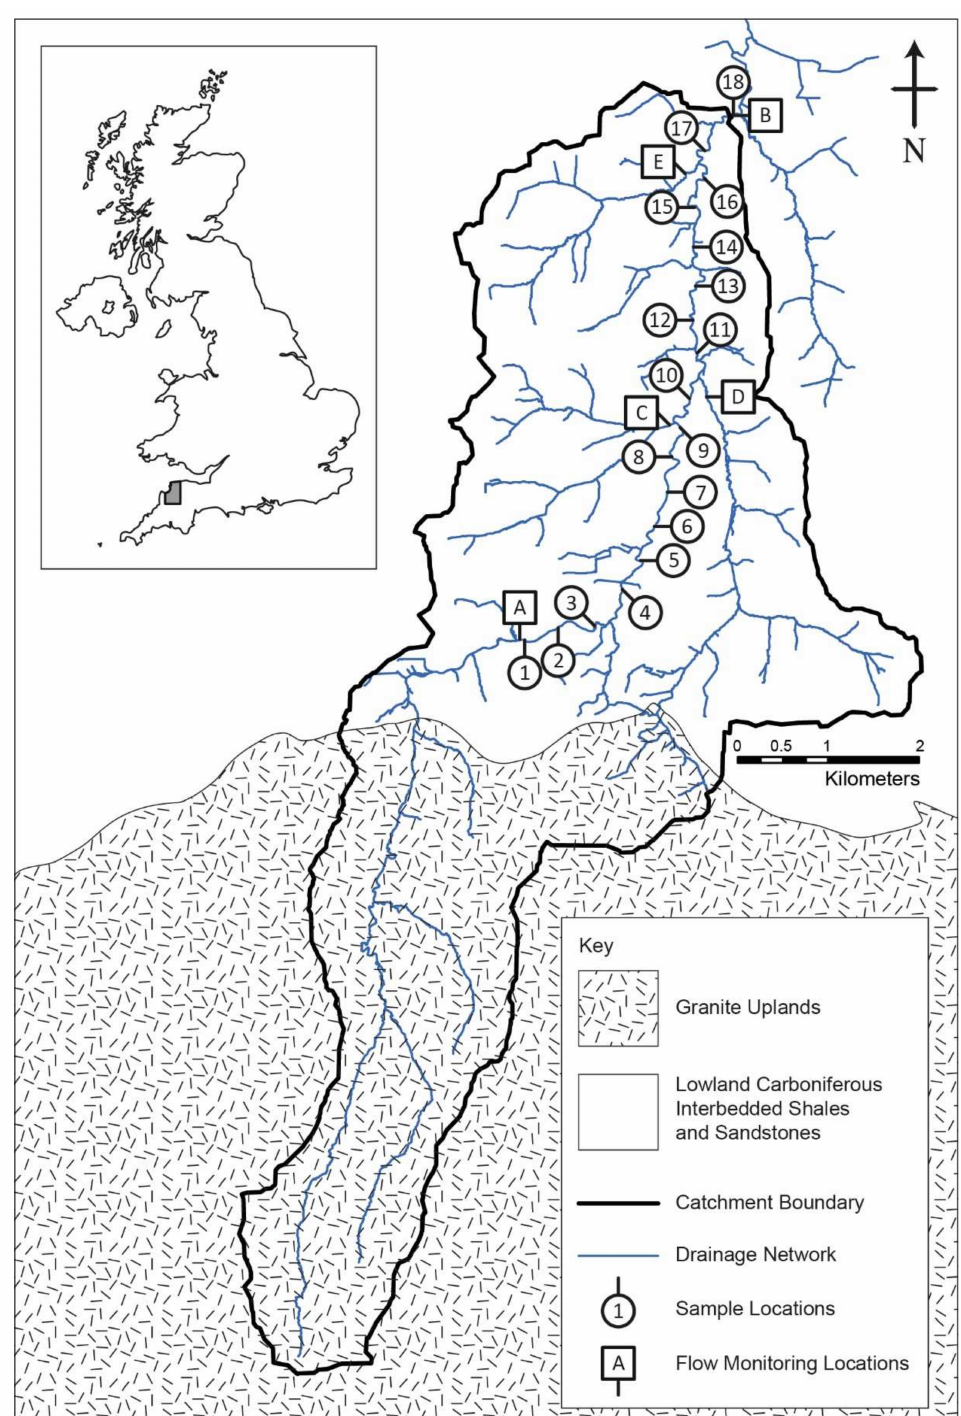
Figure 1. Map of the upper River Taw study catchment, showing location in south west England, channel bed cohesive sediment sampling locations and flow gauging